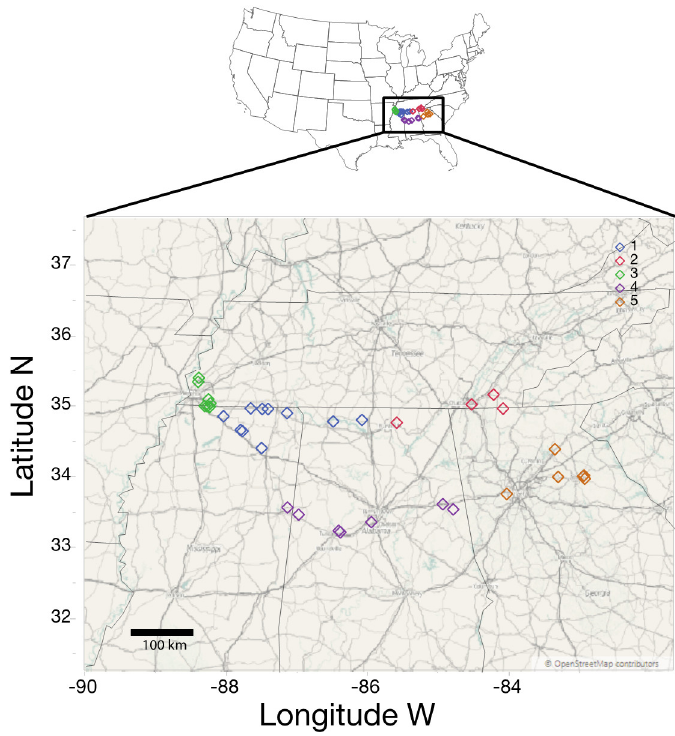
Figure 1. Map of sampling sites across the historic range of kudzu infestations in the Southeastern United States. Sampling sites are color coded based on k-means clustering into five broad location clusters used for analysis.